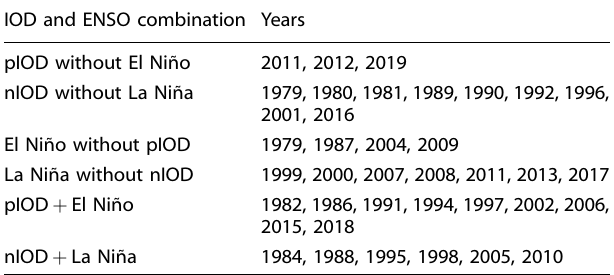
Table 1. Years of the different combinations of ENSO and IOD